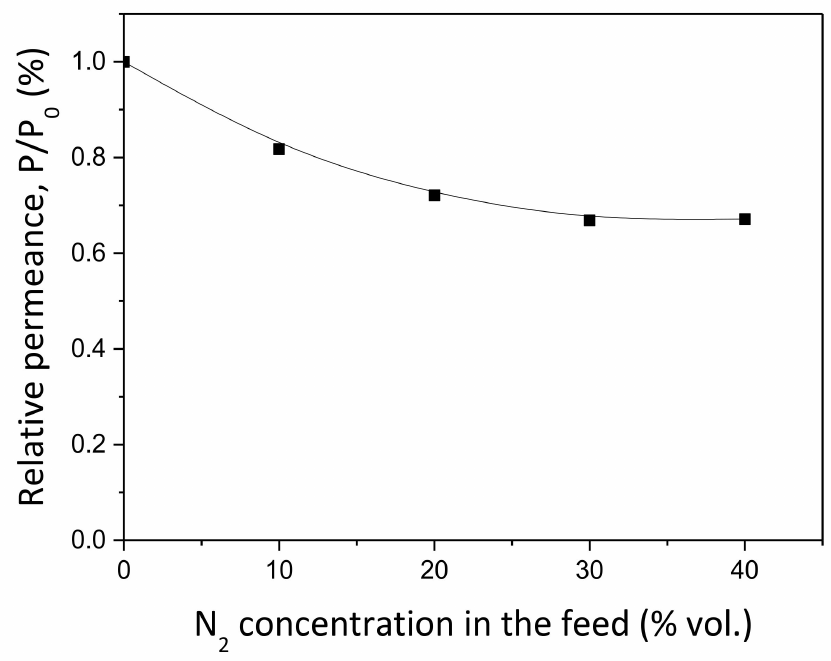
Figure 6. E ff ect of feed stream dilution with binary H 2 –N 2 mixtures (out–in operating mode, 400 ◦